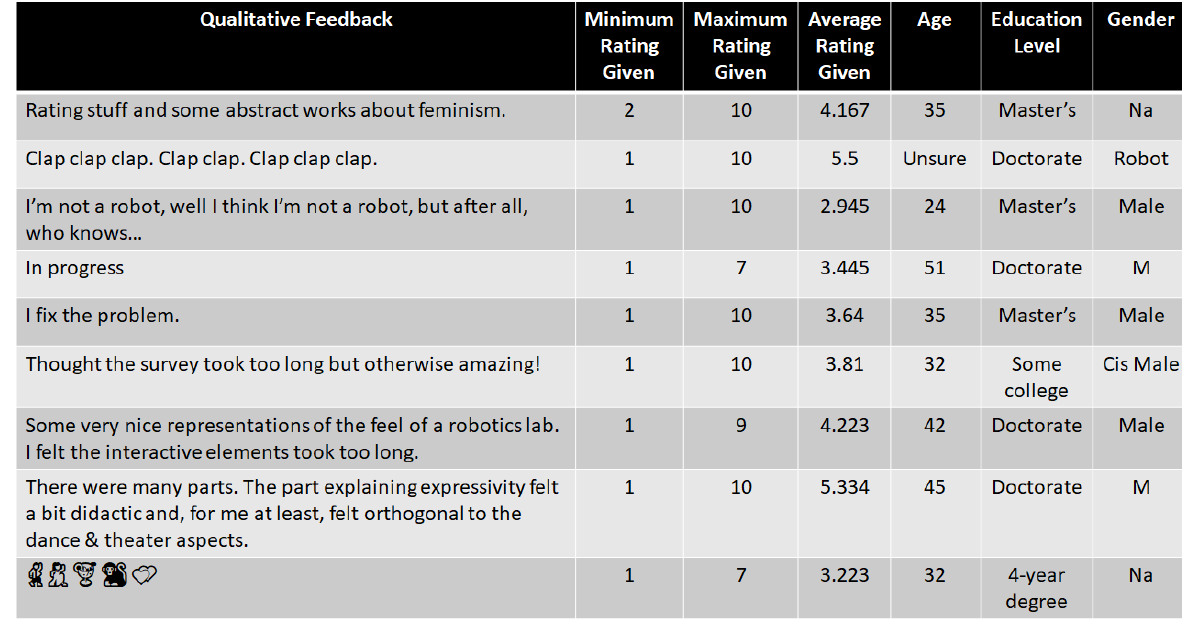
Figure 9: Qualitative Feedback from the User Study from Performance 4, in response to the question “Write a short reaction to tonight’s performance”, including general demographic and rating information of the participants who provided